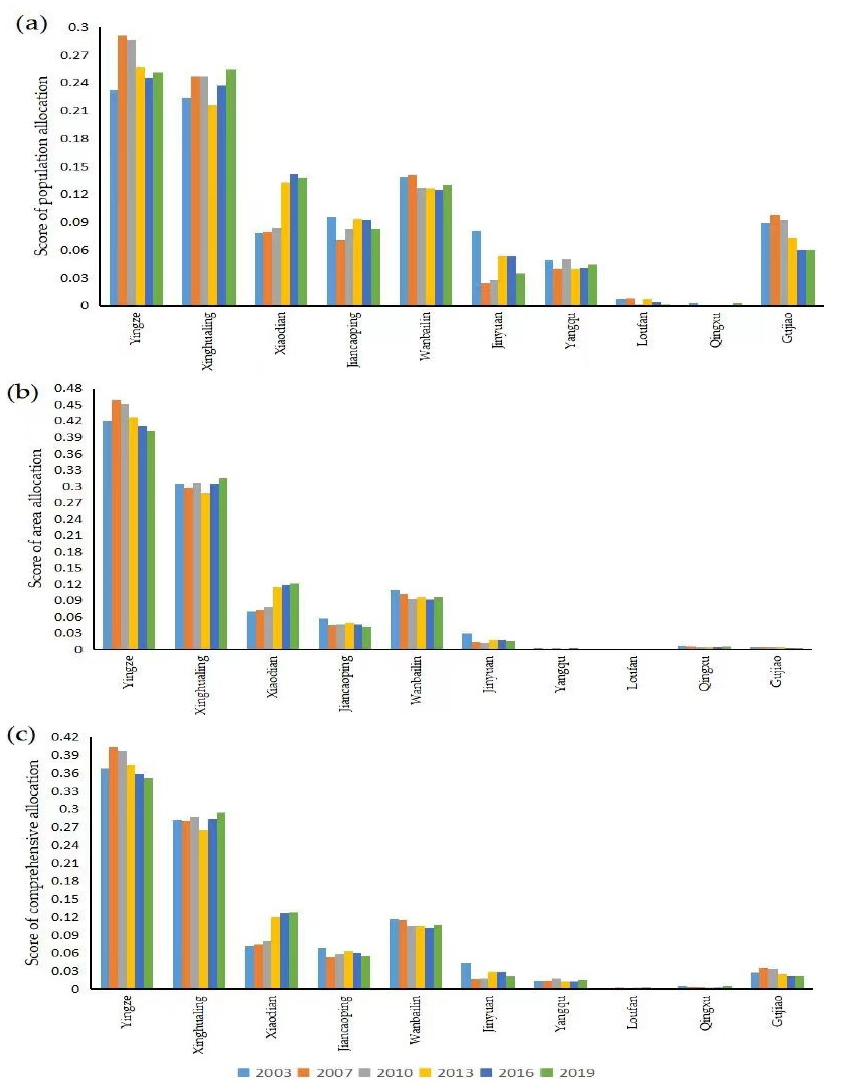
Figure 2. Score of districts and counties in Taiyuan, 2003–2019. ( a ): Population allocation; ( b ): Area allocation; ( c ): Comprehensive allocation.